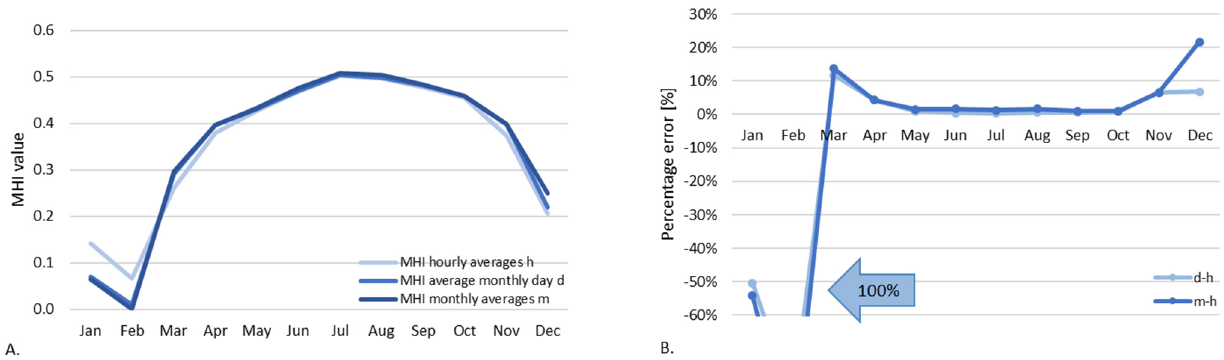
Figure 15. Rome MHI values ( A ) and percentage error ( B